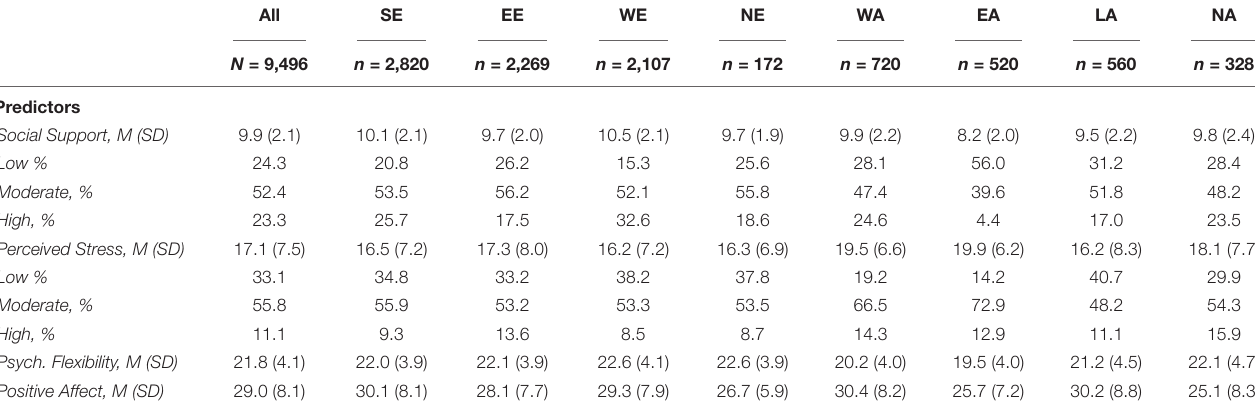
TABLE 3 | Description of predictors of the total sample and subsamples of each region. All SE